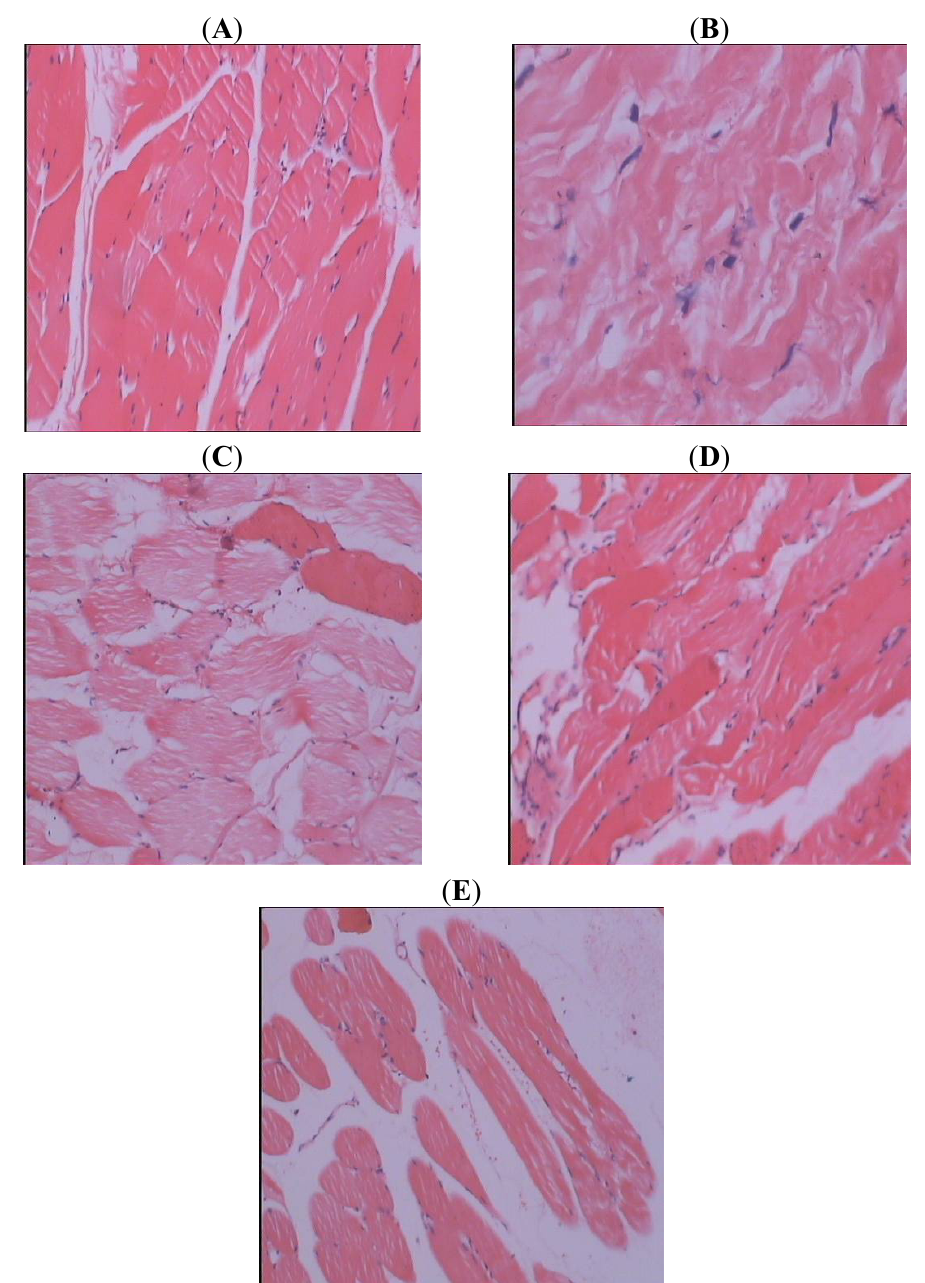
Figure 1. H&E staining A : NC; B : IR; C : IR+SJHXT (200 mg/kg/day); D :